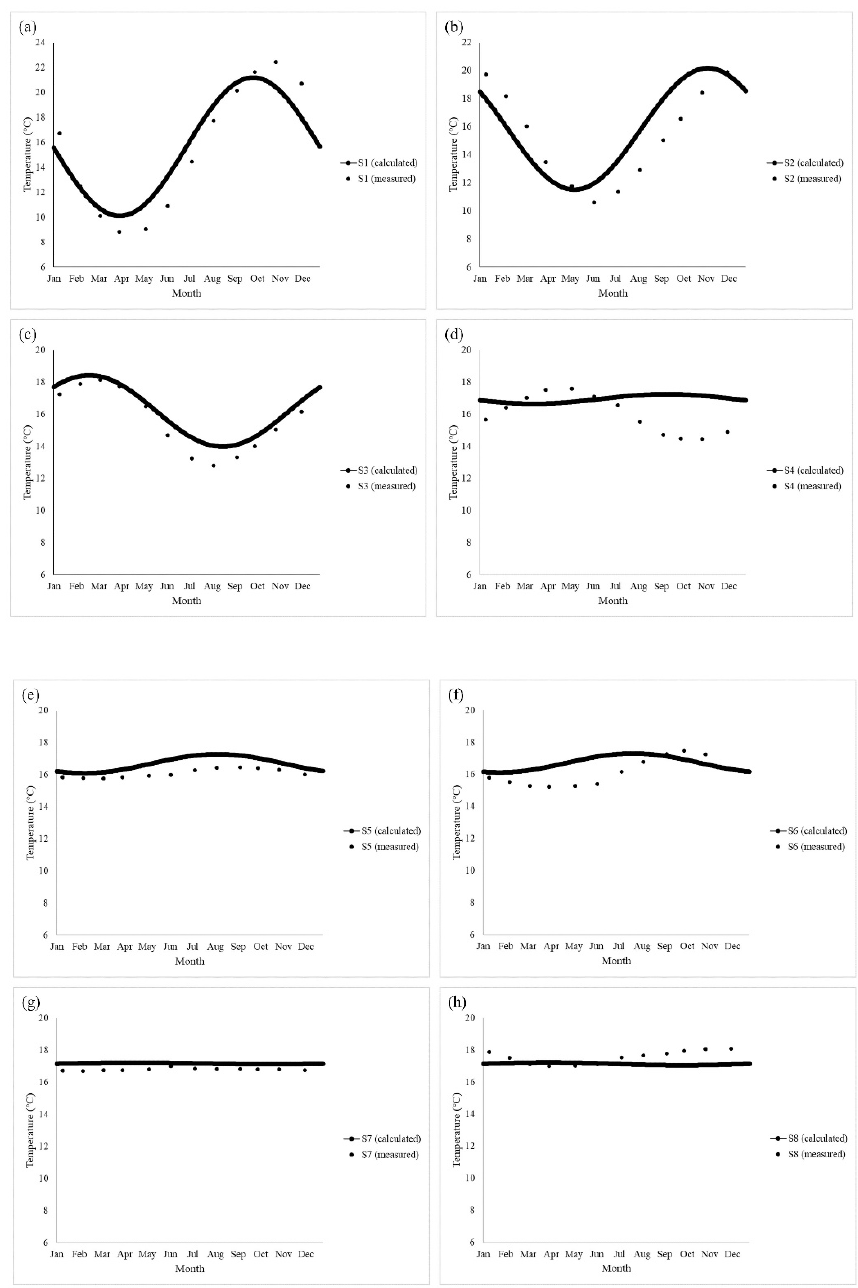
Figure 10. Comparison of the annual groundwater temperature change between the calculated and measured values on the Holocene gravel layer.